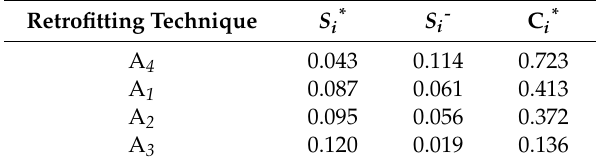
Table 13. Ranking of the Compared Intervention Options Based on MCDM